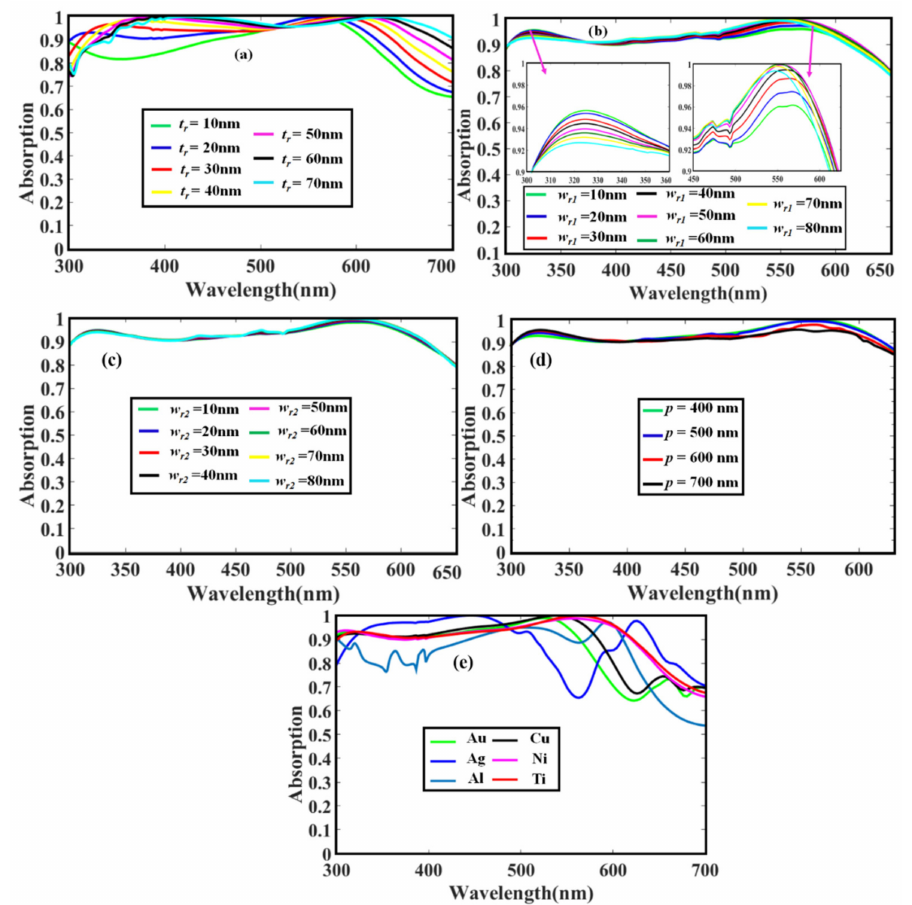
Figure 4. Impact of optical absorption e ffi ciency on ( a ) thickness of nanorings, and ( b ) width of the outer nanoring, w r1, ( c ) width of the inner ring, w r2 , ( d ) period of unit cell, and ( e ) di ff erent materials for the top